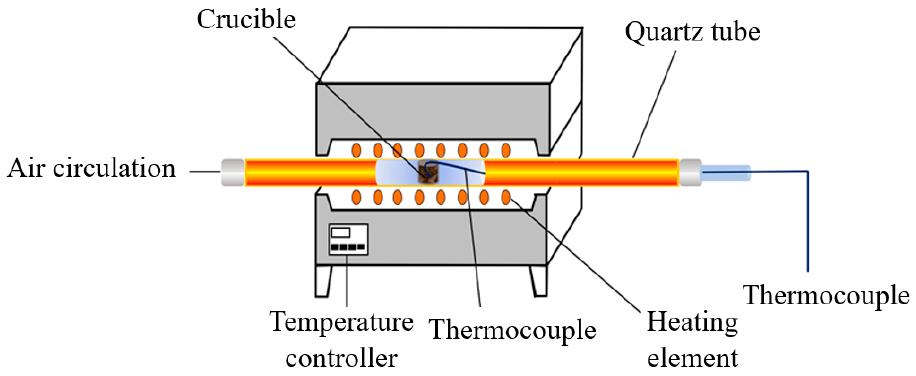
Figure 1. The fixed bed system diagram.